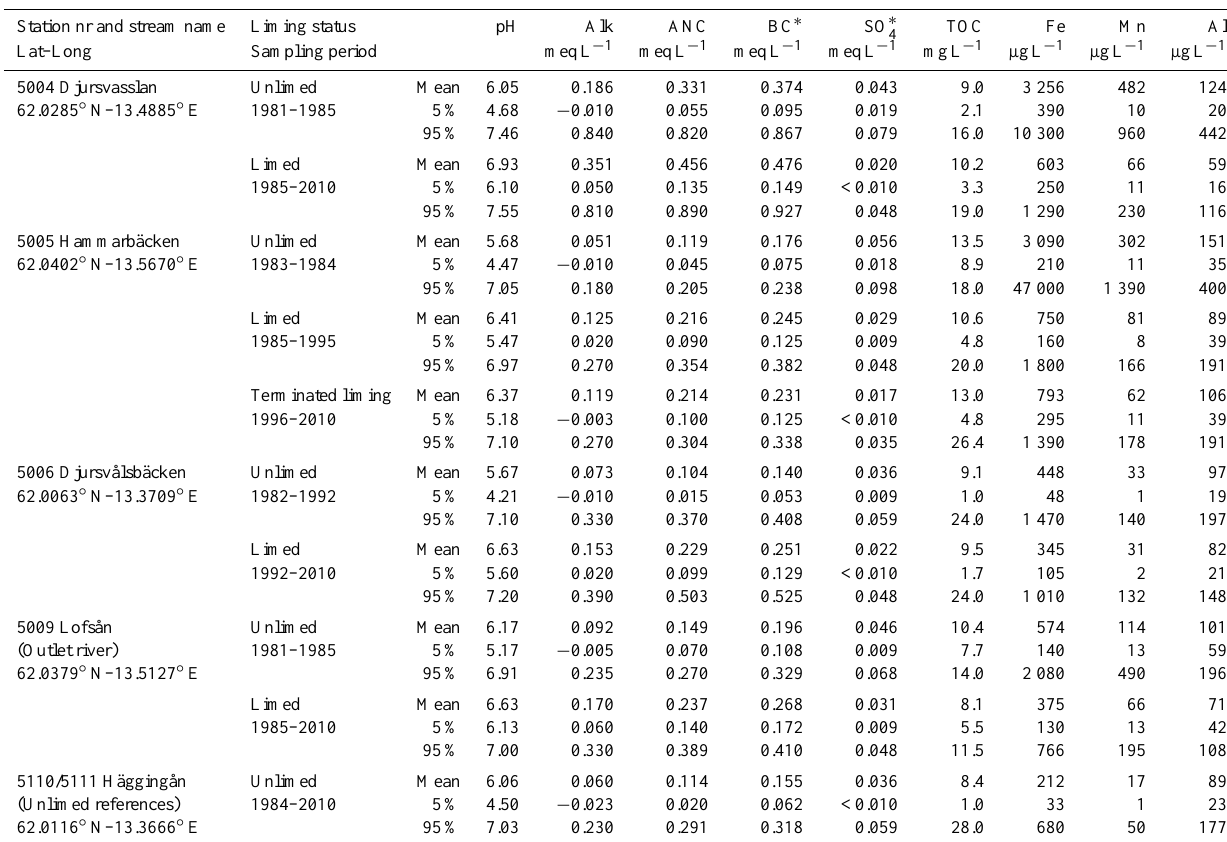
Table 1. Latitude, longitude and mean, 5 and 95 percentiles of key water chemical variables during unlimed and limed periods of the stream-sampling stations in the Lofsdalen area, province of